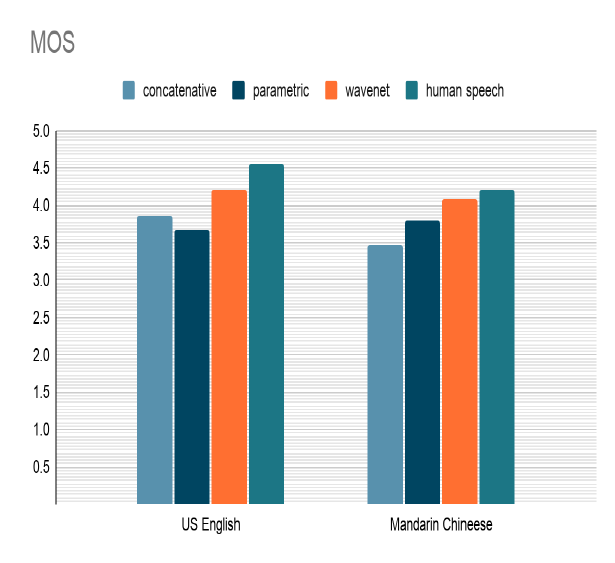
Figure 4. MOS of WaveNet’s performance compared with a parametric and concatenative approach, as well as natural